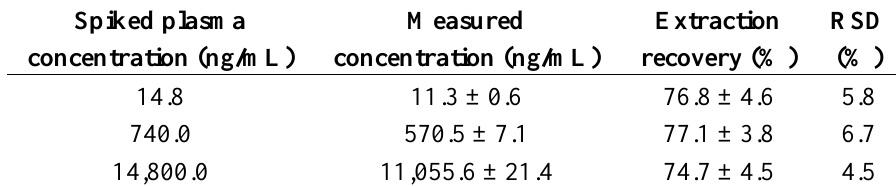
Table 2. Extraction recovery of QGR in rat’s plasma (mean ± SD, n =